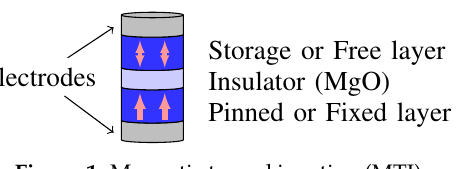
Figure 1. Magnetic tunnel junction